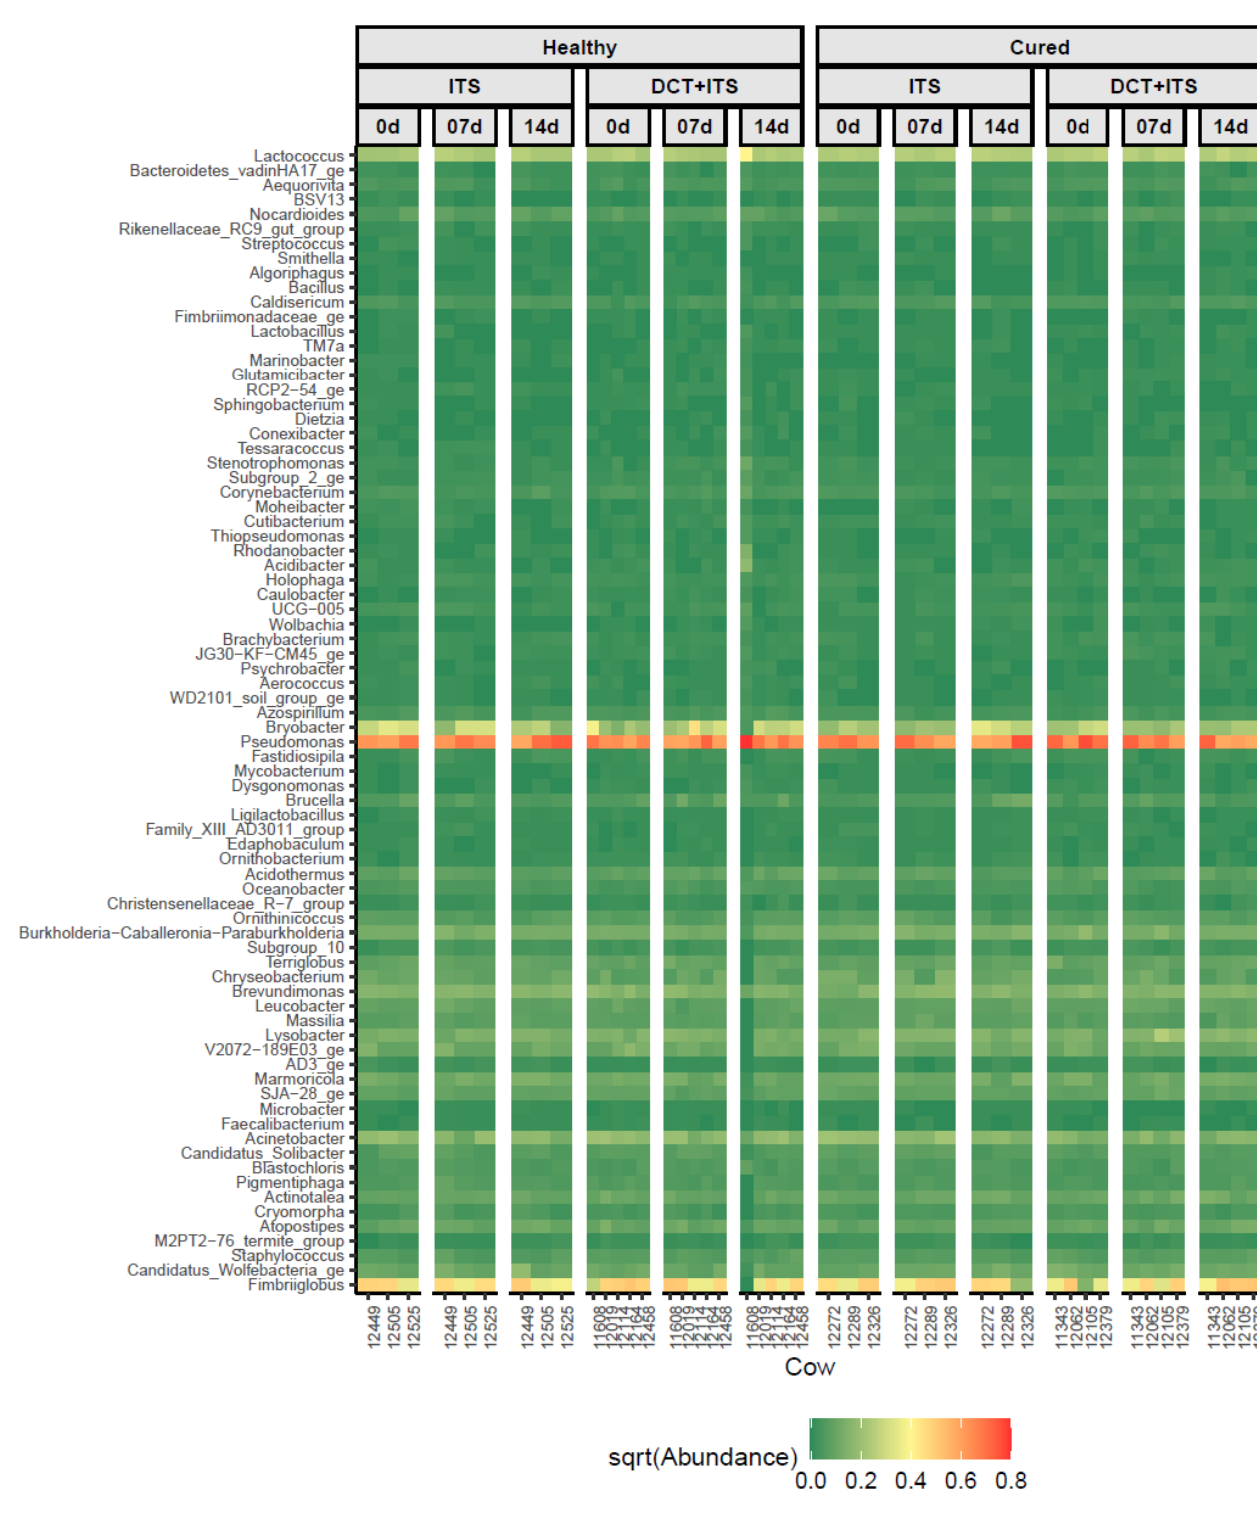
Figure 4. Distribution of the most abundant bacterial genera ( n = 78) that were present in at least 50% of all samples, among individual milk samples from cows according to category (Healthy and Cured), treatment (ITS and DCT+ITS), and time of sampling (0 d: the day of drying-off, 7 d: 7 days after calving, and 14 d: 14 days after calving). The color key represents the square root transformed (sqrt) relative abundance according to the gradient of color, from dark green (low abundance) to dark red (high